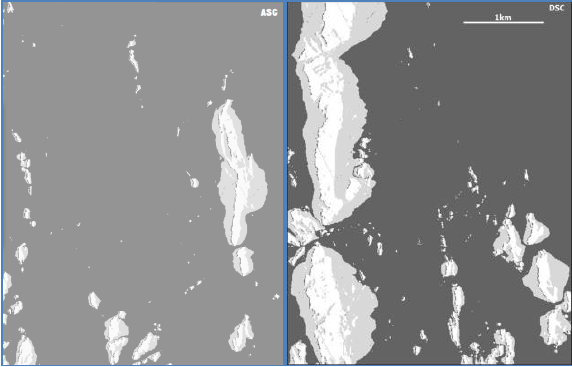
Figure 1. The overlay/shadow maps of the project area showing the areas affected by different distortion effects in ascending (left) and descending